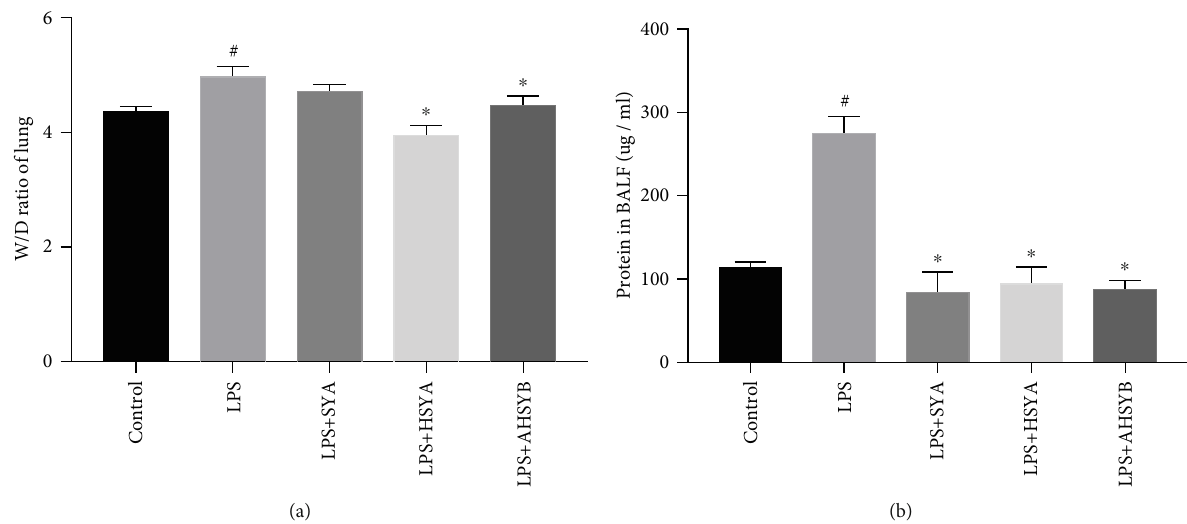
Figure 3: E ff ects of SYA, HSYA, and AHSYB on the edema in LPS-induced ALI. (a) Lung tissues were weighed to calculate the W/D ratio. (b) BCA assay was used to determine the total protein concentration in BALF. The values presented are mean ± SEM , # P < 0 : 05 vs the control group; ∗ P < 0 : 05 vs the LPS